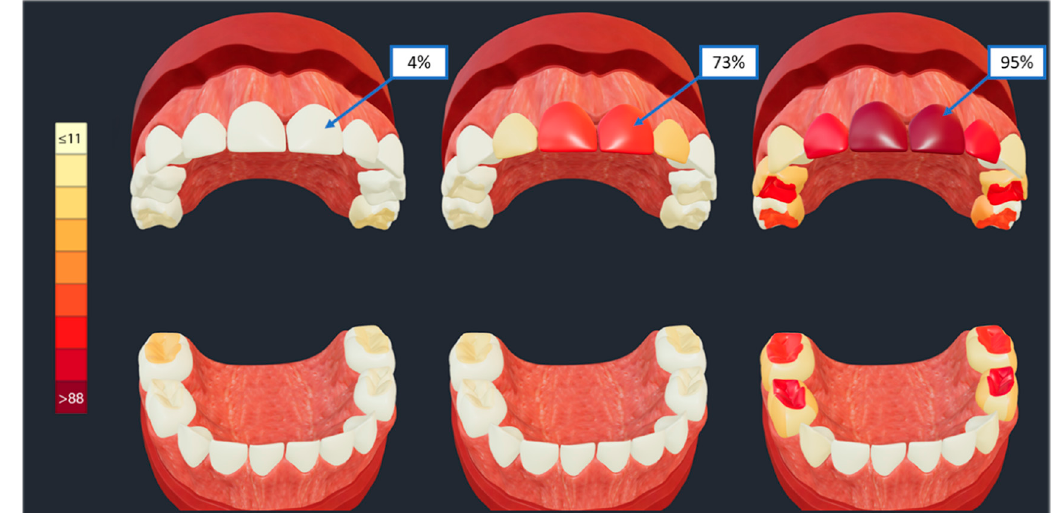
Figure 5. A research application of SculptorHD. Clinical subtypes of early childhood caries were generated using LCA of tooth-surface level caries experience data from over 6000 child participants of the ZOE 2.0 study. Tooth surface-level probabilities of caries experience within each disease subtype are displayed in these three representative models (i.e., maxillary central incisors have caries experience in 4% of children represented by the left model, 73% in the middle model, and 95% in the right model), enabling clinical interpretation: the models enable the illustration of caries affection of different sets of teeth and tooth surfaces and at varying levels of severity or frequency.